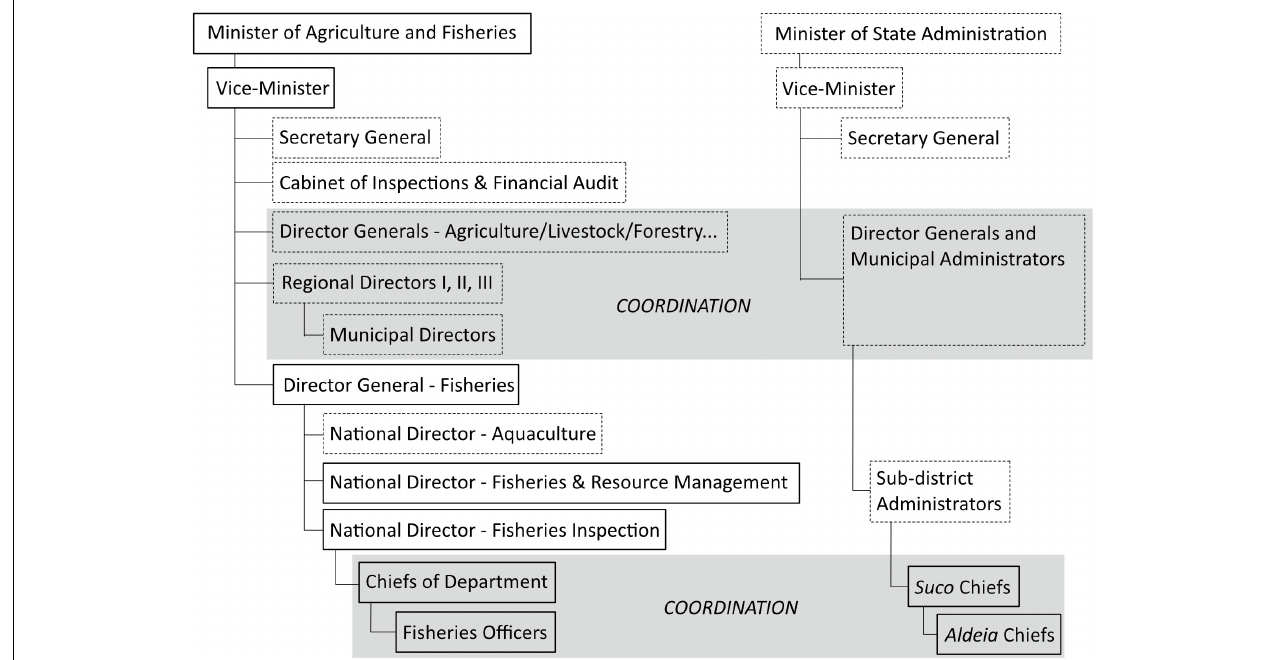
FIGURE 2 | The hierarchical structure of fisheries related departments of Timor-Leste’s Ministry of Agriculture and Fisheries, and at what levels these coordinate with municipal, suco and village level governance under the Ministry of State Administration.